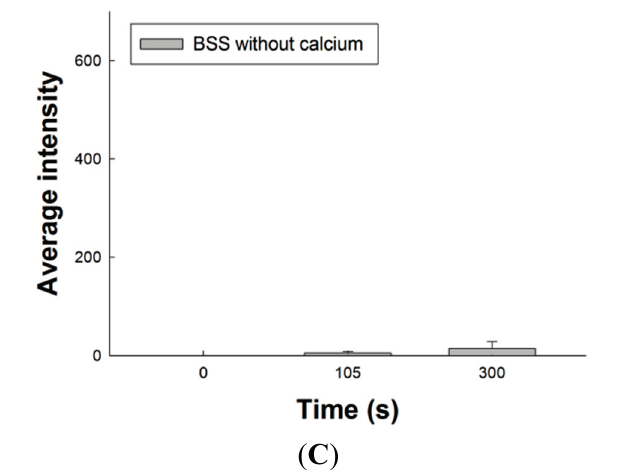
Figure 5. Effects of SM extracts on the fluorescence intensity of Ca 2+ signaling in primary LES cells stained with fluo-4-acetoxymethyl ester and detected by confocal microscopy. SM extracts were diluted as 0.5 μ L/mL in Ca 2+ -containing or Ca 2+ -free BSS. The SM extracts were added at the 60th s ( A ) The three images of upper row show the fluorescence intensity of Ca 2+ signaling in primary LES smooth muscle cells increased significantly in the Ca 2+ -containing BSS after SM treatment. On the contrary, there was no significant change in the Ca 2+ -free BSS after SM treatment; ( B ) The mean relative fluorescence intensity (F − F 0 , where F 0 = the first image of the sequence and F = subsequent images) in smooth muscle cells at the 300th s in the Ca 2+ -containing BSS after SM treatment increased significantly; ( C ) The mean relative fluorescence intensity in smooth muscle cells at the 105th or 300th s in the Ca 2+ -free BSS after SM treatment did not increase significantly. Scale bar represents 40 μ m. * Significant difference between these two groups at p <